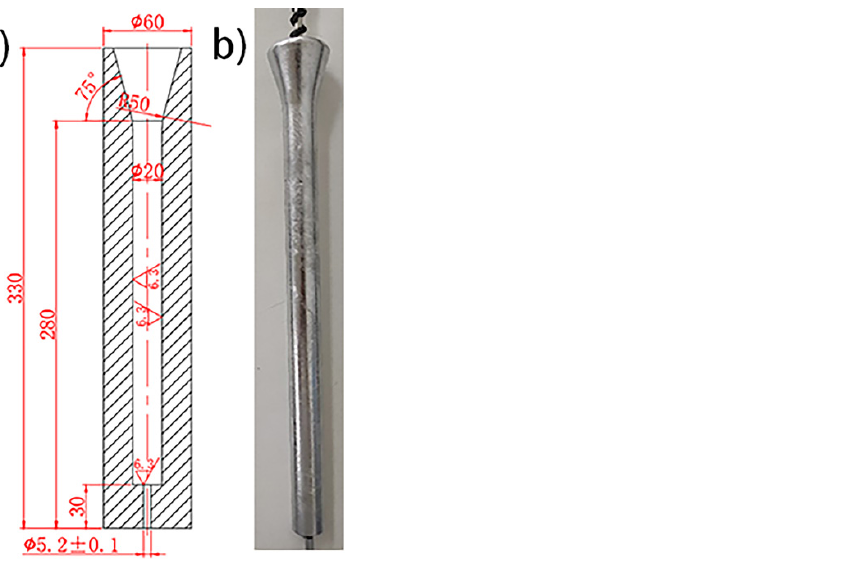
Figure 2. Mold and composite bars: ( a ) graphite mold; ( b ) composite bar.